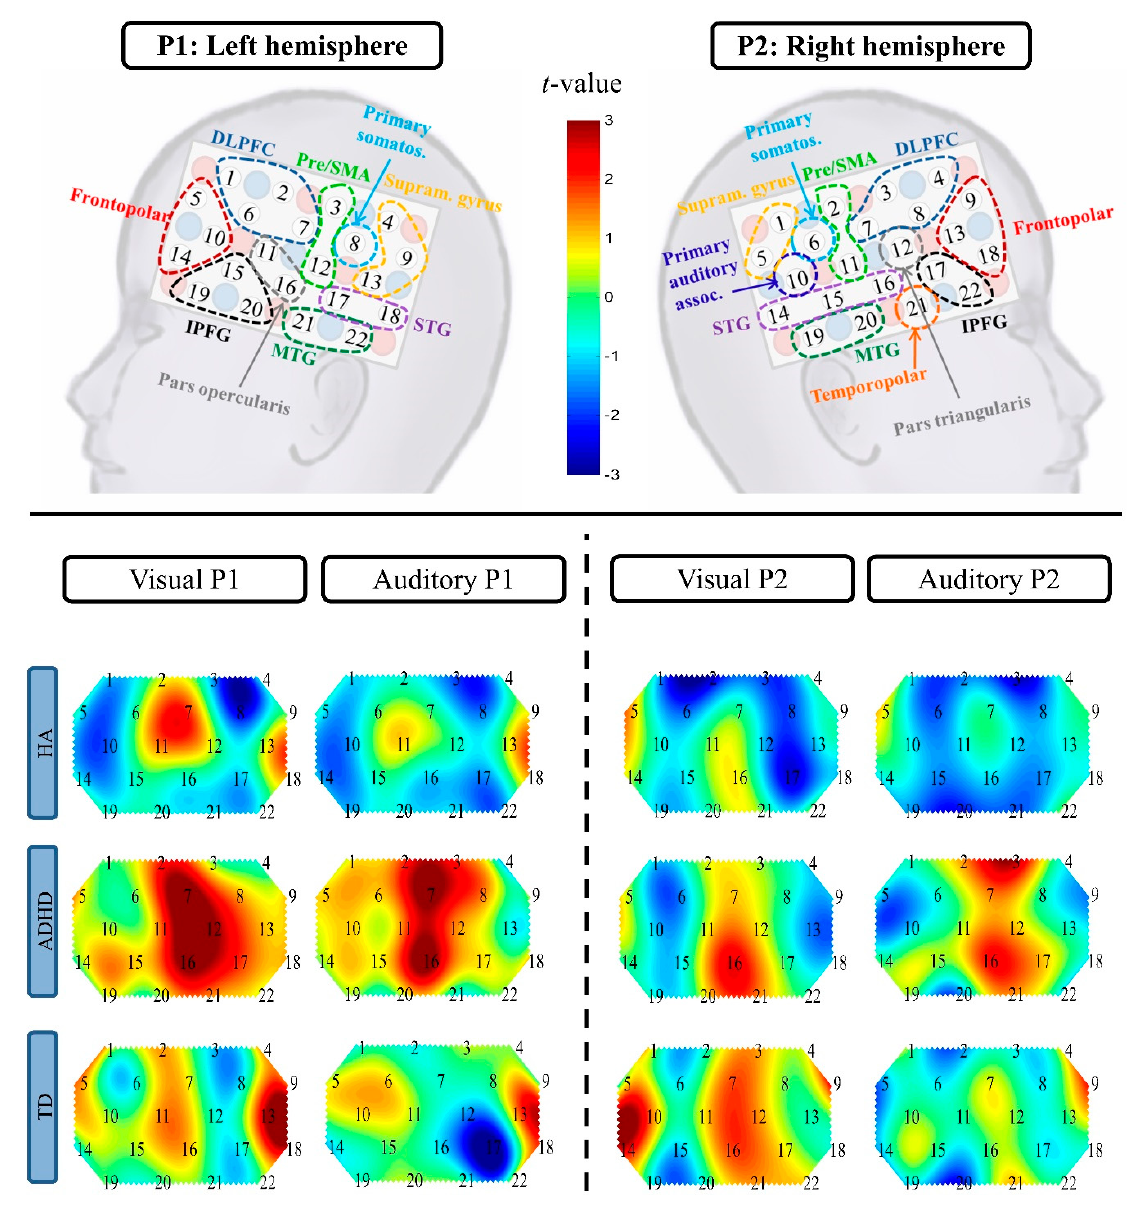
Figure 4. Heat maps ( t -maps) of the ∆ HbR contrast against baseline per group (HA, ADHD, TD) and condition (auditory, visual). The respective t-values can be found in Table S3. Abbreviations: P, Probe set; DLPFC, dorsolateral prefrontal cortex; pre / SMA, pre-motor and supplementary motor area; STG, superior temporal gyrus; MTG, medial temporal gyrus; IPFG, inferior prefrontal gyrus; primary somatos., primary somatosensory cortex; primary auditory assoc., primary auditory association cortex; supram. gyrus, supramarginal gyrus; HA, hearing aid; ADHD, attention deficit / hyperactivity disorder; TD, typically developing.